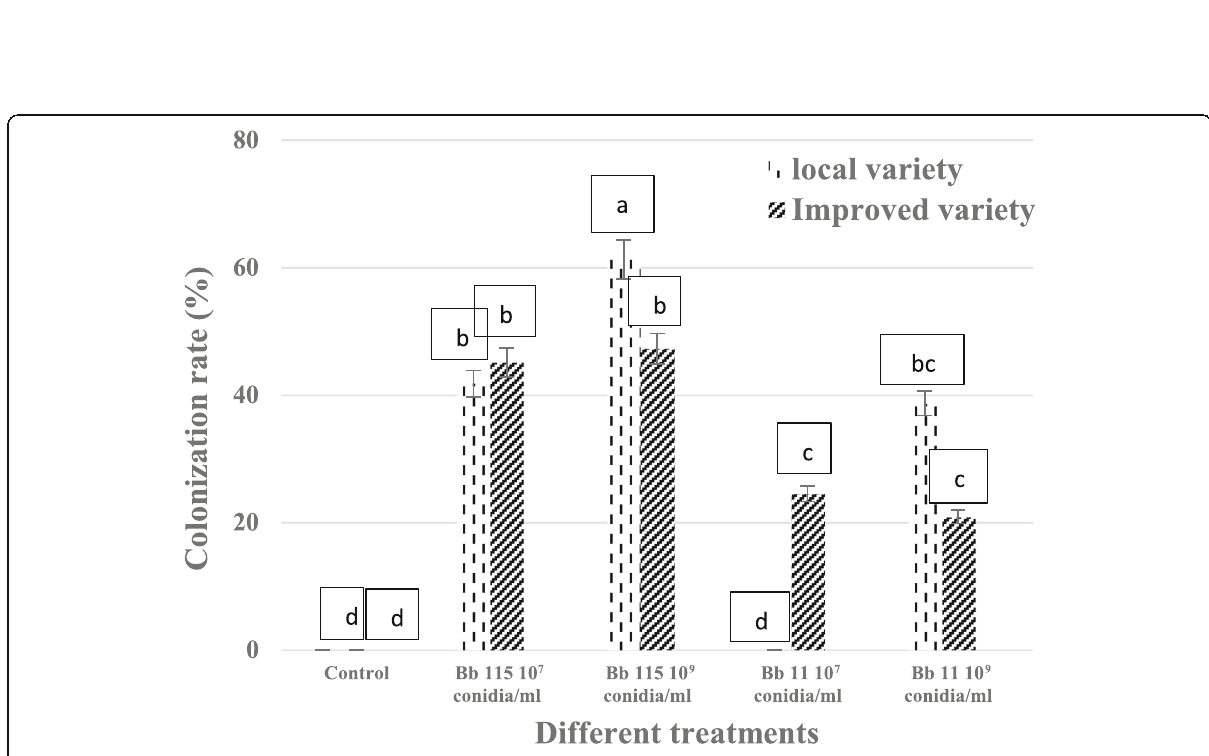
Fig. 3 Stem colonization rate (%) by Beauveria bassiana in two tomato varieties with seed coating inoculation. Histograms with the same letters are not significantly different at the 5% level (SNK). With Bb115 10 7 conidia/ml = Beauveria bassiana Bb115 at 10 7 conidia/ml; Bb115 10 9 conidia/ ml = Beauveria bassiana Bb115 at 10 9 conidia/ml; Bb11 10 7 conidia/ml = Beauveria bassiana Bb11 at 10 7 conidia/ml; Bb11 10 9 conidia/ml = Beauveria bassiana Bb11 at 10 9